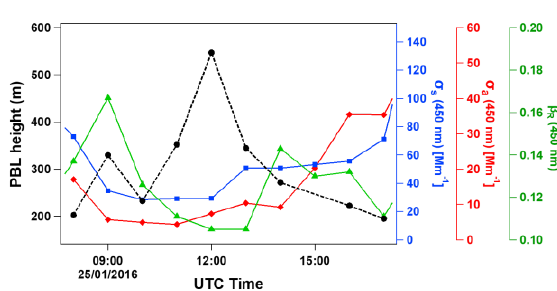
Figure 7 Temporal evolution of the hourly means of PBL height from the RCS-SD (black dots), aerosol scattering σ s and absorption σ a coefficient at 450 nm (blue boxes and red diamonds, respectively), and backscatter ratio β R at 450 nm (green triangles) on 25 January